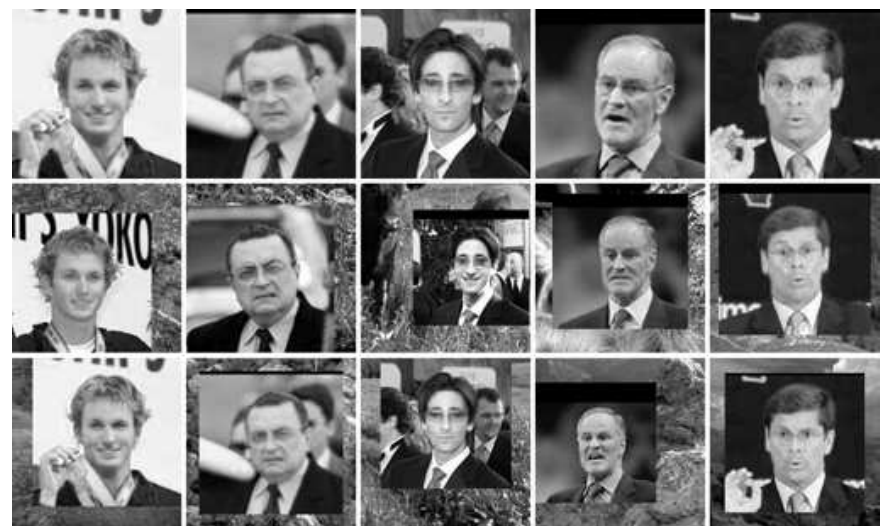
Figure 3: Face Images and Parts of the Training Pictures.